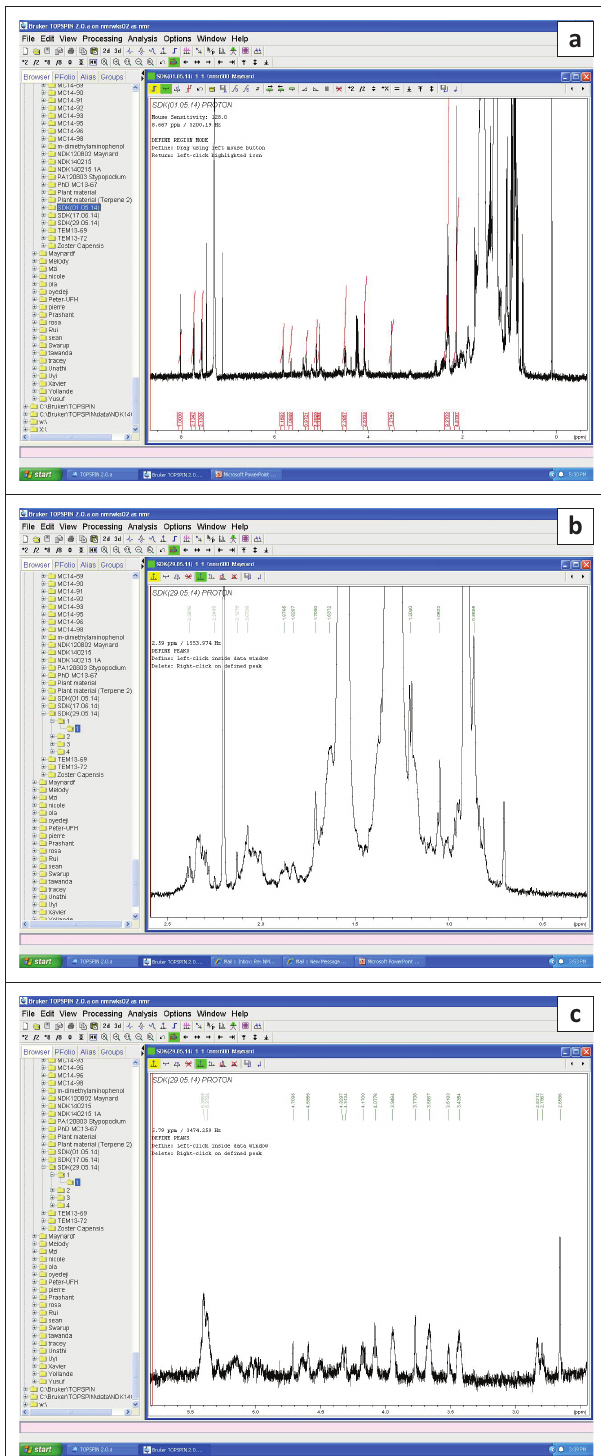
FIGURE 4: 1 H NMR spectrum of the isolated compounds. NMR, nuclear magnetic